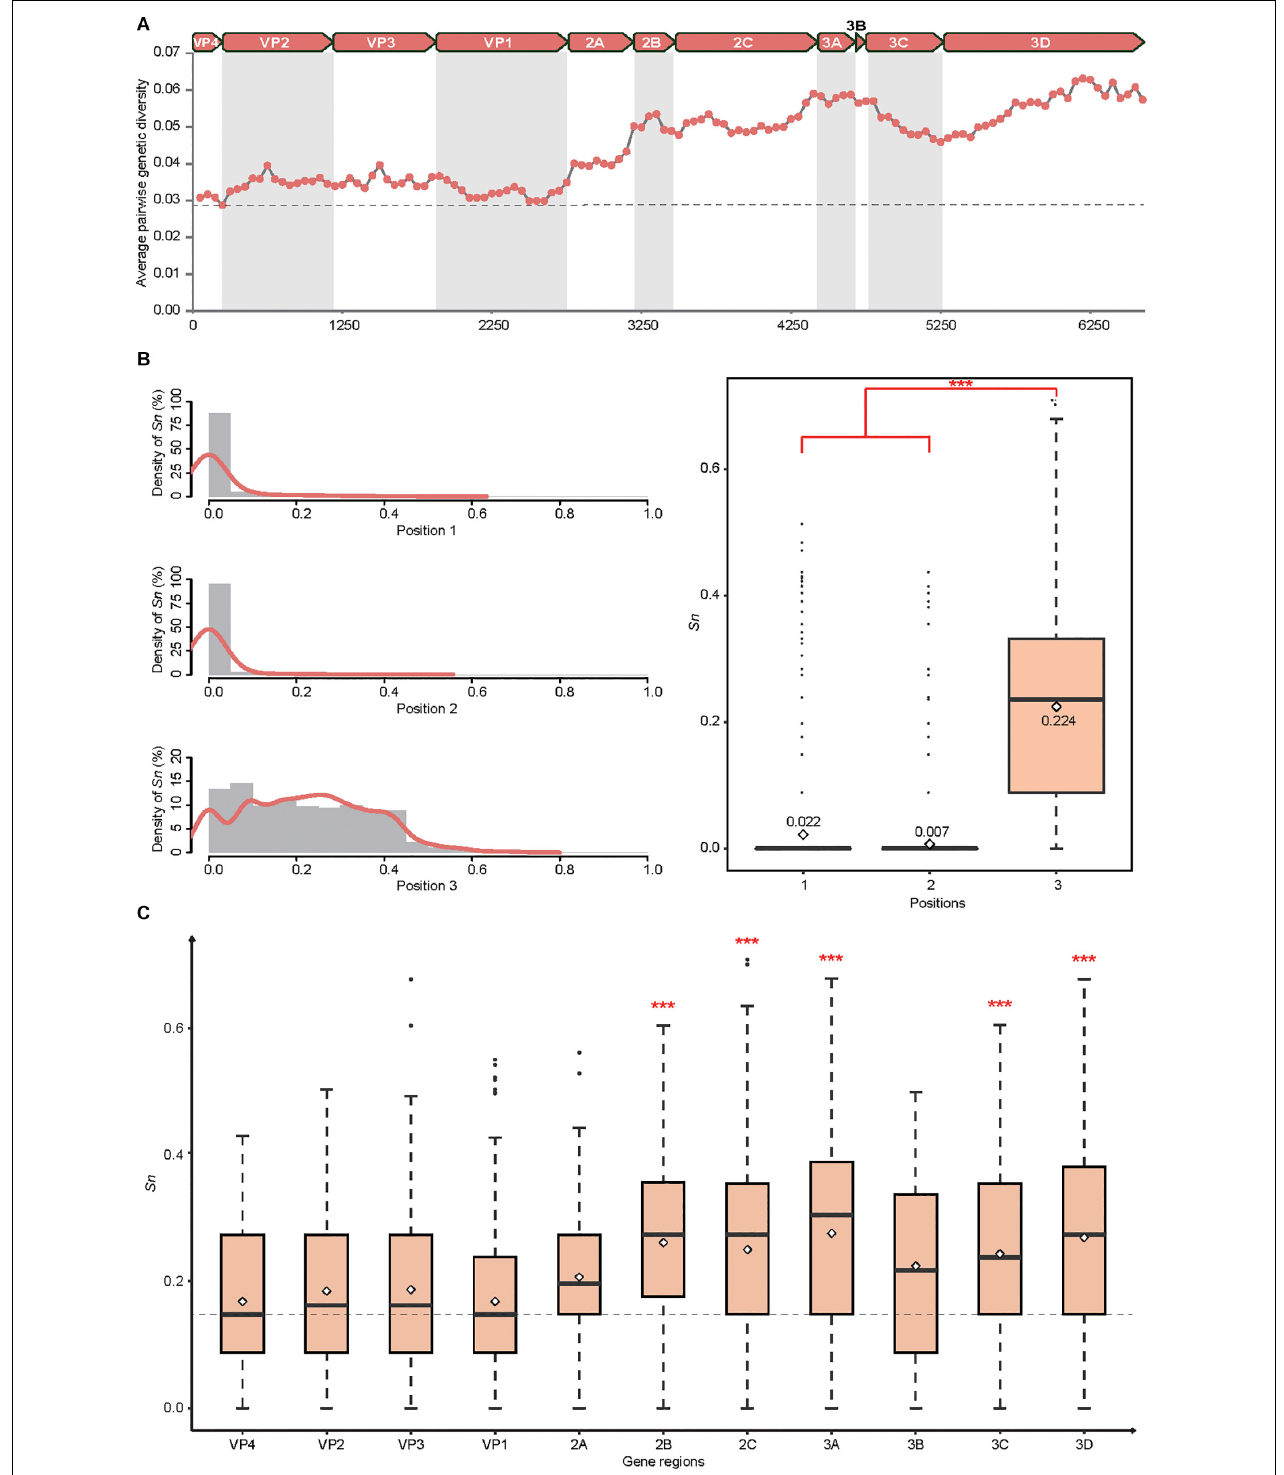
FIGURE 2 | Genetic diversity of the CVA4 polyprotein genes ( n = 31). (A) Average pairwise genetic diversity of all CVA4 polyprotein genes was calculated using a sliding window of 300 nts with a step size of 50 nts. (B) Positional entropy values and the Sn values at partitions 1, 2, and 3 of each codon were estimated, respectively. ∗∗∗ p -value < 0.001 in the Wilcoxon rank-sum test. (C) The Sn values of nucleotides at positions three of the codons were estimated in VP4, VP2, VP3, VP1, 2A, 2B, 2C, 3A, 3B, 3C, and 3D genes, respectively. ∗∗∗ p -value < 0.001 in the Wilcoxon rank-sum test between 2B, 2C, 3A, 3C, 3D genes and VP4, VP2, VP3, VP1 genes,